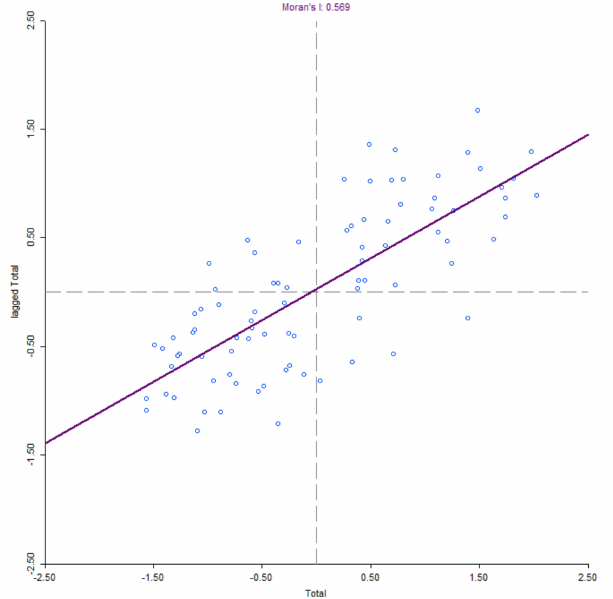
Figure 3. Moran’s scatterplot of data on the level of socio-economic vulnerability (Source: Results of secondary data processing, 2020).